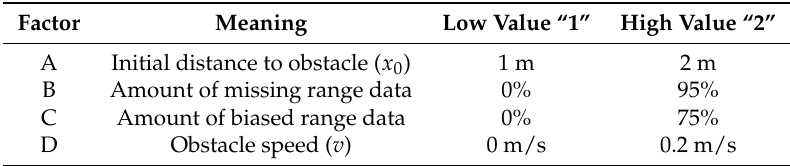
Table 2. Factors influencing the performance of Bayesian range filters along with the concrete values that they can take, including both scenario parameters and sensor anomalies. In this work, we will be using “1” and “2” to refer to the low and high values of the factors respectively.